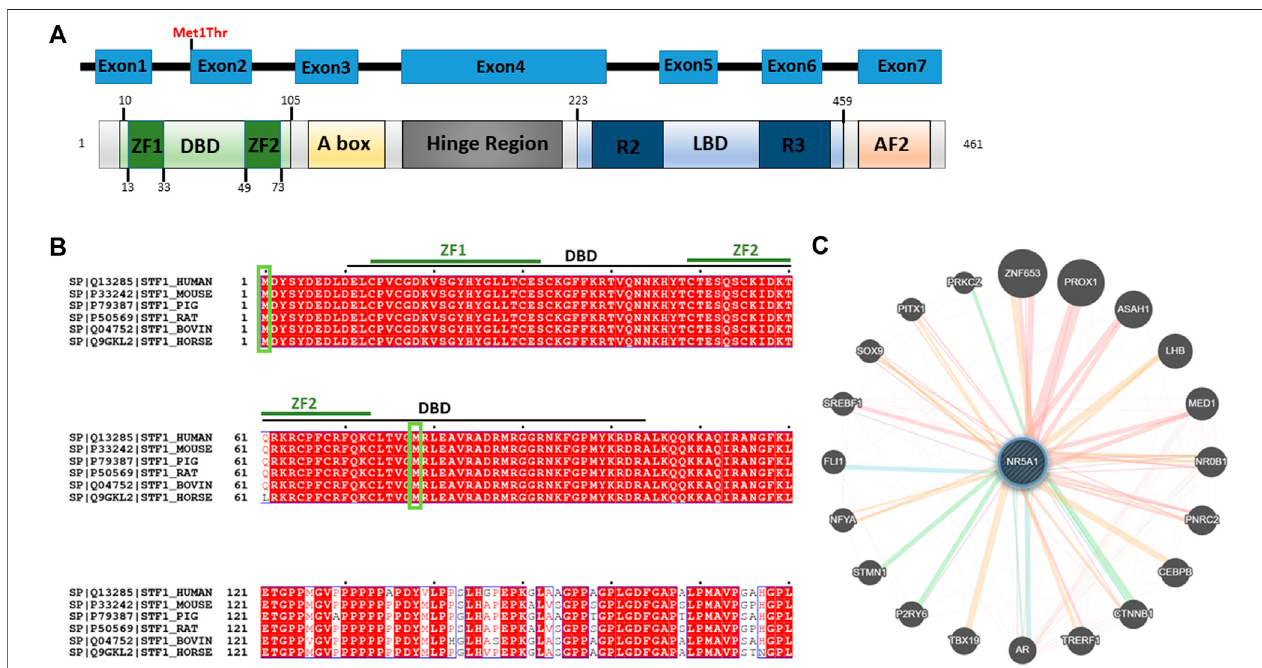
FIGURE3 | Predicted effectofMet1Thr mutation on NR5A1 function. (A) Schematic diagram ofthe identi fi ed variant at amino acid 1 islocated on the DBD (green) in the N-terminus of NR5A1. The diagram was generated using PROSITE (https://prosite.expasy.org/cgi-bin/prosite). (B) Alignment of the sequences of H. Sapiens NR5A1 (UniProt: Q13285) with the Mouse NR5A1 (UniProt: P33242), Pig NR5A1 (UniProt: P79387), Rat NR5A1 (UniProt: P50569), Bovin NR5A1 (Uniprot: Q04752), and Horse NR5A1 (UniProt: Q9GKL2). The alignment was generated using UniProt Align (http://www.uniprot.org/align/). Start codon (Met) are represented by green rectangles. The alignment fi le was generated using UniProt Align (http://www.uniprot.org/align/), and fi nal processing was performed in ESPript (http://espript. ibcp.fr). (C) Schematic representation of the NR5A1 interactions with other proteins using GeneMANIA (http://genemania.org/): physical interaction with other proteins (pink lines), genetics interaction (green lines), co-localization (blue lines), and predicted interaction (orange lines).